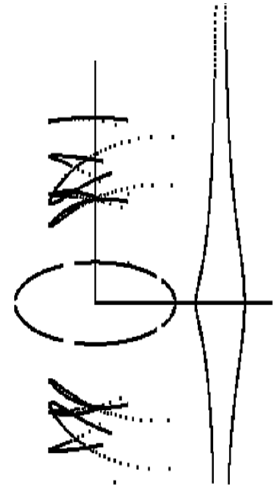
Figure 16. q = 2, KG = 100, and DK = 140.